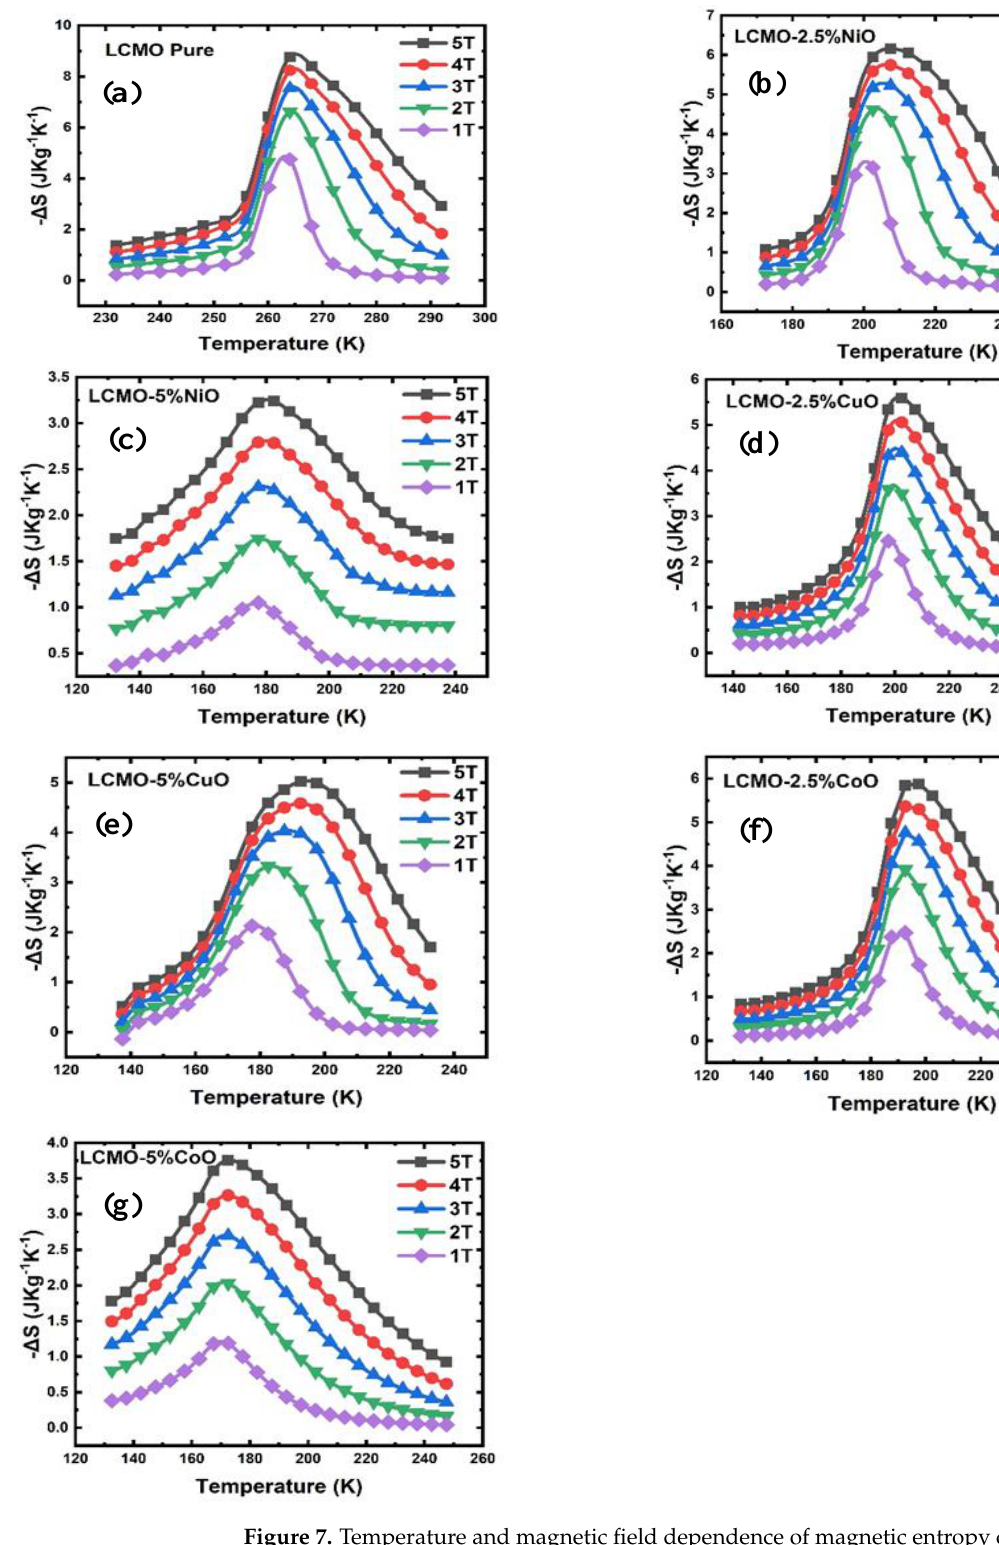
Figure 7. Temperature and magnetic field dependence of magnetic entropy change for LCMO–MO composite samples ( a ) LCMO-pure, ( b ) LMCO-2.5% NiO, ( c ) LMCO-5% NiO, ( d ) LCMO-2.5% CuO, ( e ) LCMO-5% CuO, and ( f ) LCMO-2.5%CoO, ( g ) LCMO-5%CoO.